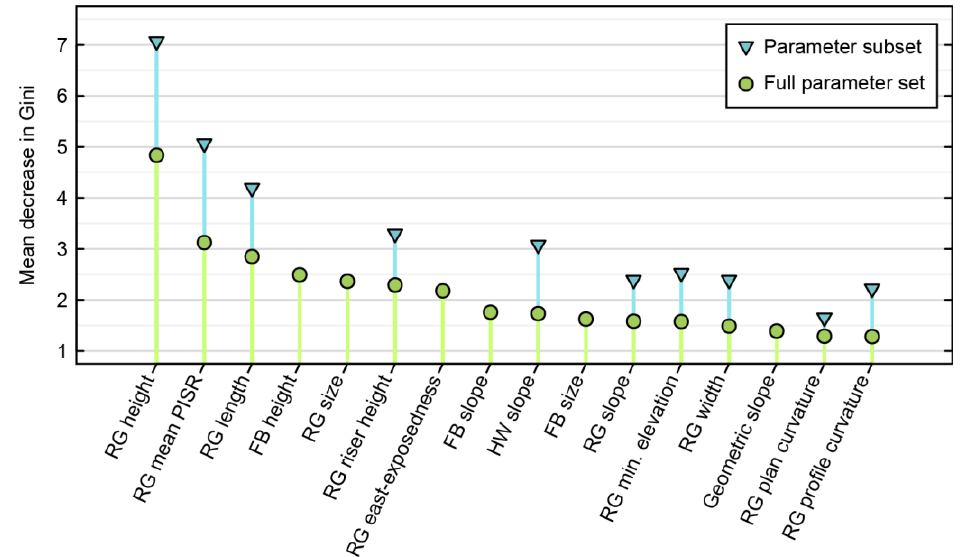
Figure 9. Variable importance within random forest classification models of rock glacier activity, shown as mean decrease in Gini coefficient. Results are shown for models derived from full parameter set (green lines and points) and parameter subset (blue lines and triangles), respectively. Note that the mean decrease in Gini coefficient is a relative measure and values are not comparable between the two models. Abbreviations are: RG = rock glacier, FB = Feeder basin, HW = headwall.